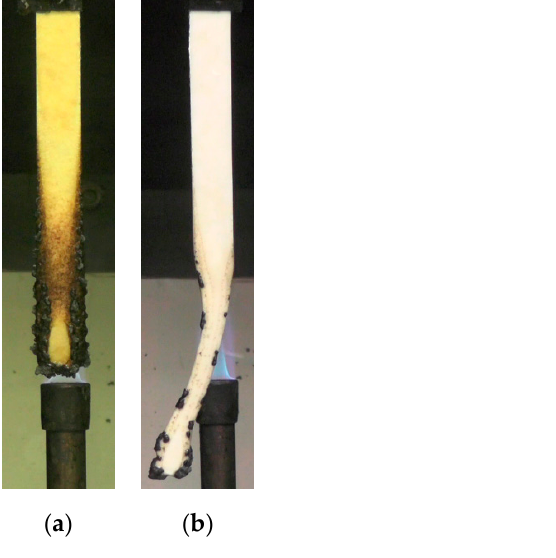
Figure 10. Samples after vertical burn tests: ( a ) PP-15% APP-20% LAC and ( b ) PP-20% APP